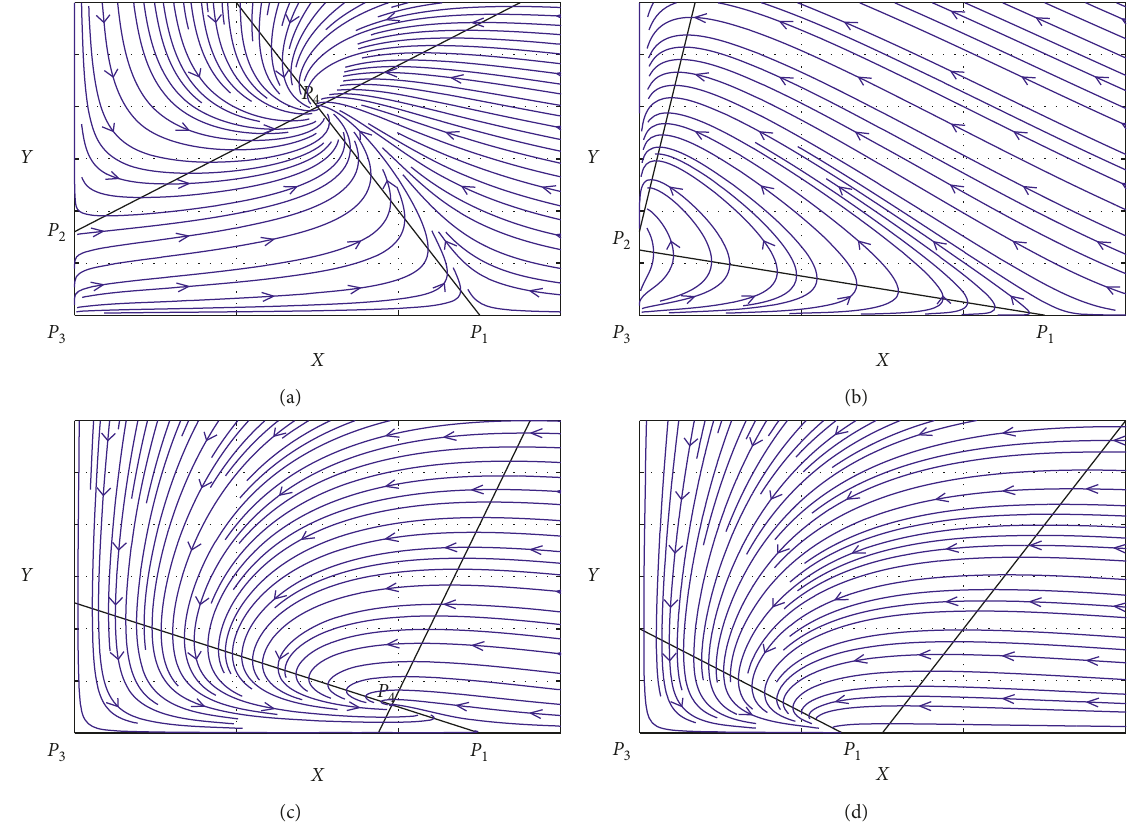
Figure 2: Phase diagrams: (a) 0 < R